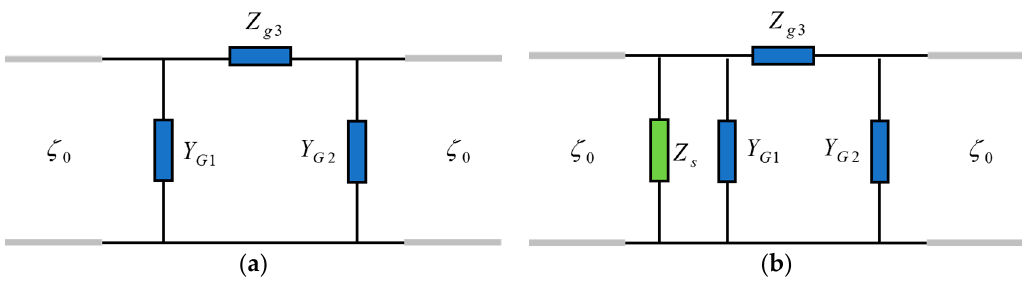
Figure 19. Equivalent circuit of the waveguide junction in the absence ( a ) or presence ( b ) of the impedance sheet.